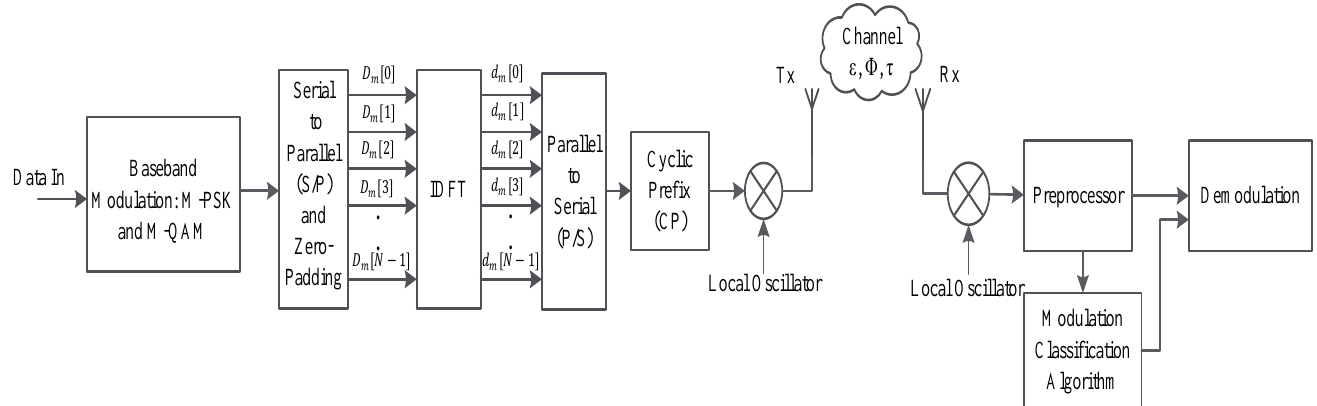
Figure 2. Block diagram of blind modulation classification for OFDM